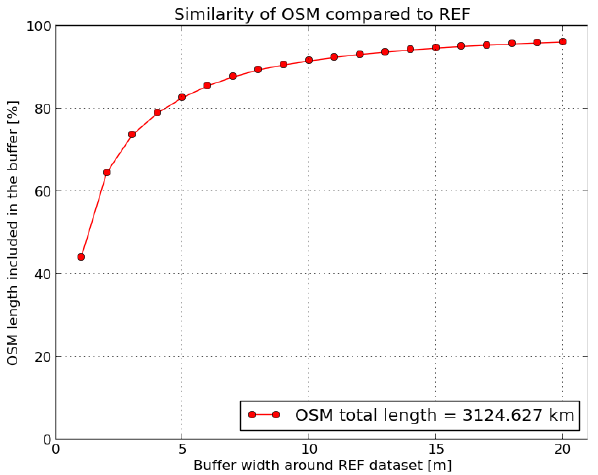
Figure 1. Length of Paris OSM roads (as a percentage of their total length) included in the buffers from 1 to 20 m around the Paris IGN road